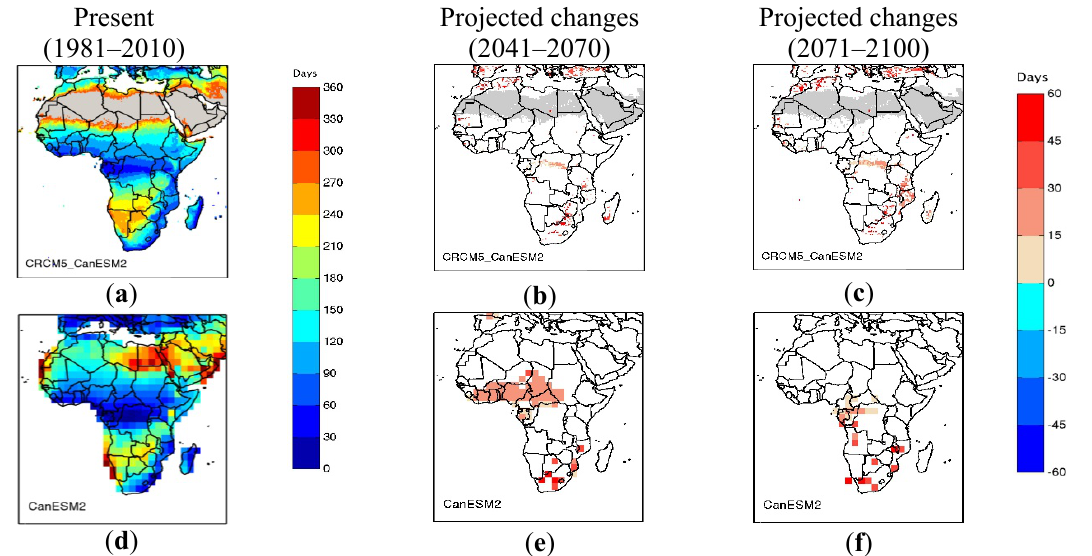
Figure 12. Same as Figure 6, but for the 5-year return level of the annual maximum dry spell duration. The grid points where the return levels are larger than 365 days are masked in grey